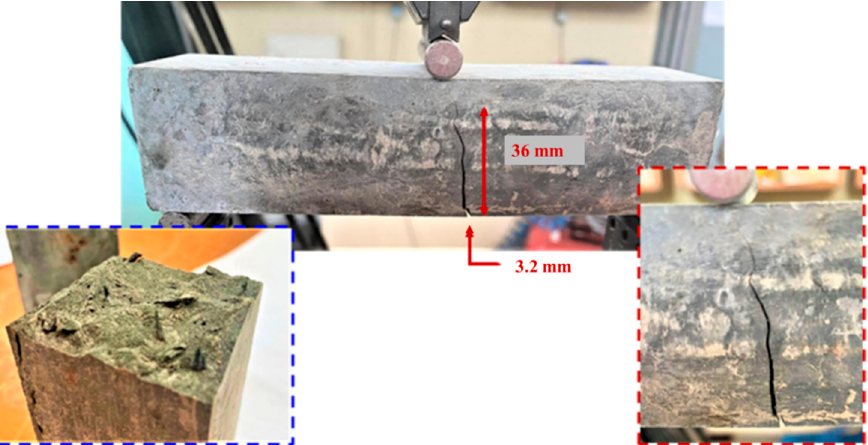
16 of 23 Figure 14. Crack width and length after bending test and CFs concentration at the rupture interface in the case of wet mixing of CFs adding CNC. ( a ) ( b ) ( c ) Figure 15. CFs concentration at the rupture interface in the case of ( a ) wet mixing of CFs adding CMC, ( b ) wet mixing of CFs adding CNC, and ( c ) Plain cement paste. Furthermore, in Figures 16 and 17, the crack width of the specimen with the dry mix-